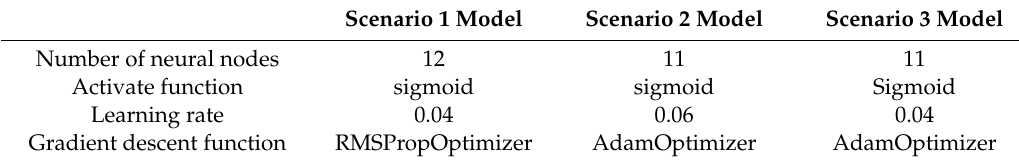
Figure 6. Determining the hyperparameters of neural network models in scenario 1: ( a ) error changes of number of neural nodes; ( b ) error changes of activation function; ( c ) error changes of learning rate; ( d ) error changes of gradient descent function. Table 4. Choices of hyperparameters for neural network models at three scenarios.